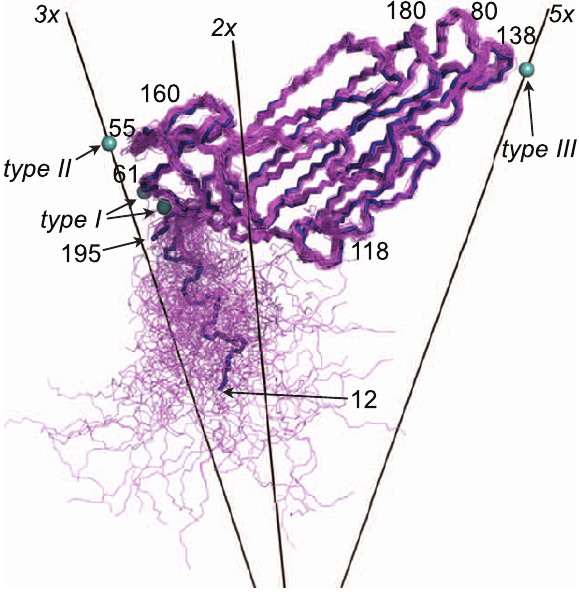
Figure 1. Fold of the coat protein. The main chain of all 60 proteins in Sim NoCa D neut after 1 m s (violet) aligned to the crystal structure (blue). Symmetry axes and Ca 2 z binding sites of all types are indicated, along with residues mentioned in the text.